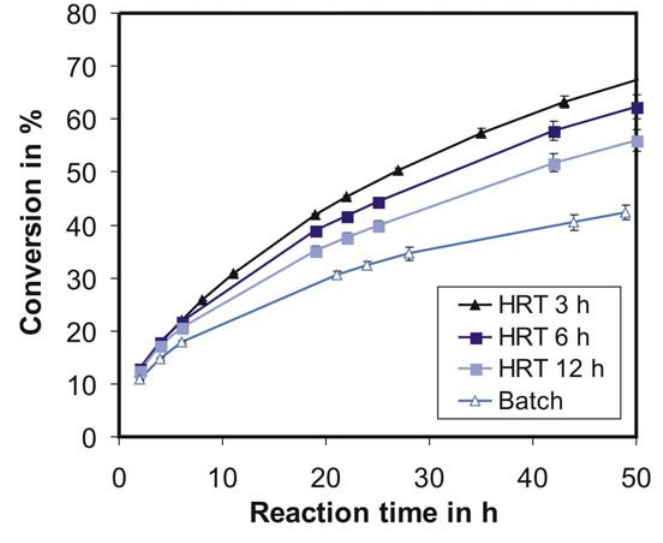
= 1120 U/L, c = 25 g/L, E S,0